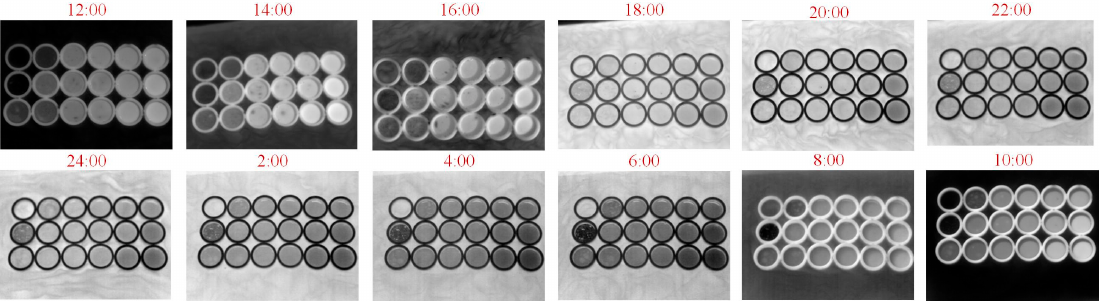
Figure 3. Thermal infrared bright temperature image.